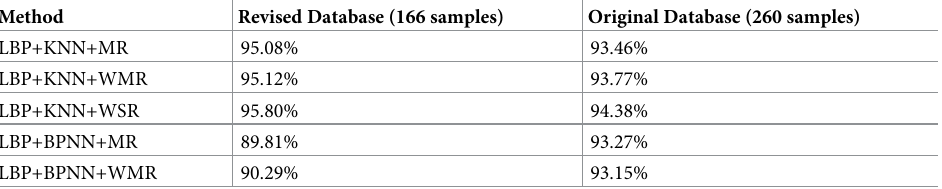
Table 9. Comparison of average classification results with two databases in 10x10